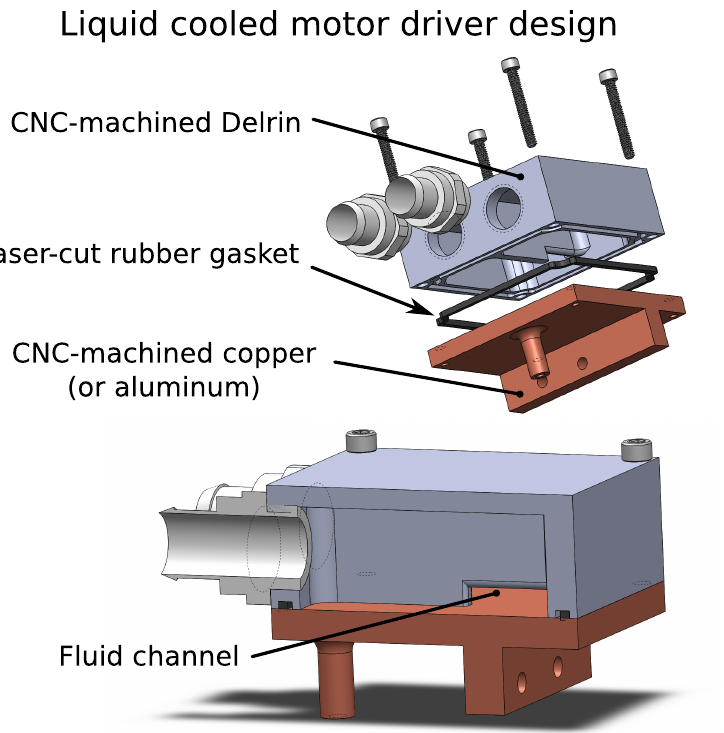
Figure 4. Design of a casing to house and circulate cooling fluid around the Advanced Motion Controls AZB60A8 motor